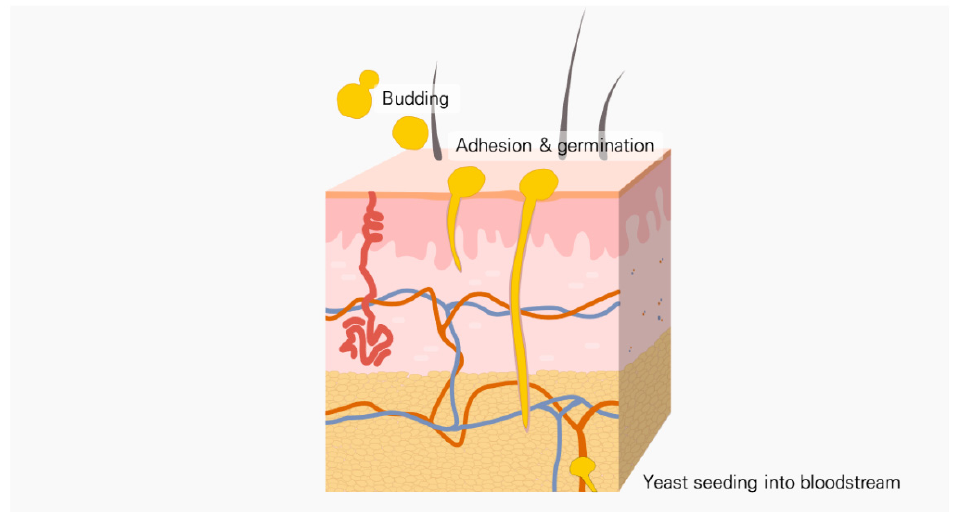
Figure 2. Pathogenesis of candidiasis. Candida adheres to the epithelium and then germinates. Candida degrades host protein, and the hyphae penetrate the surrounding tissue. After this, seeding in the bloodstream or colonization in the endothelium is performed.